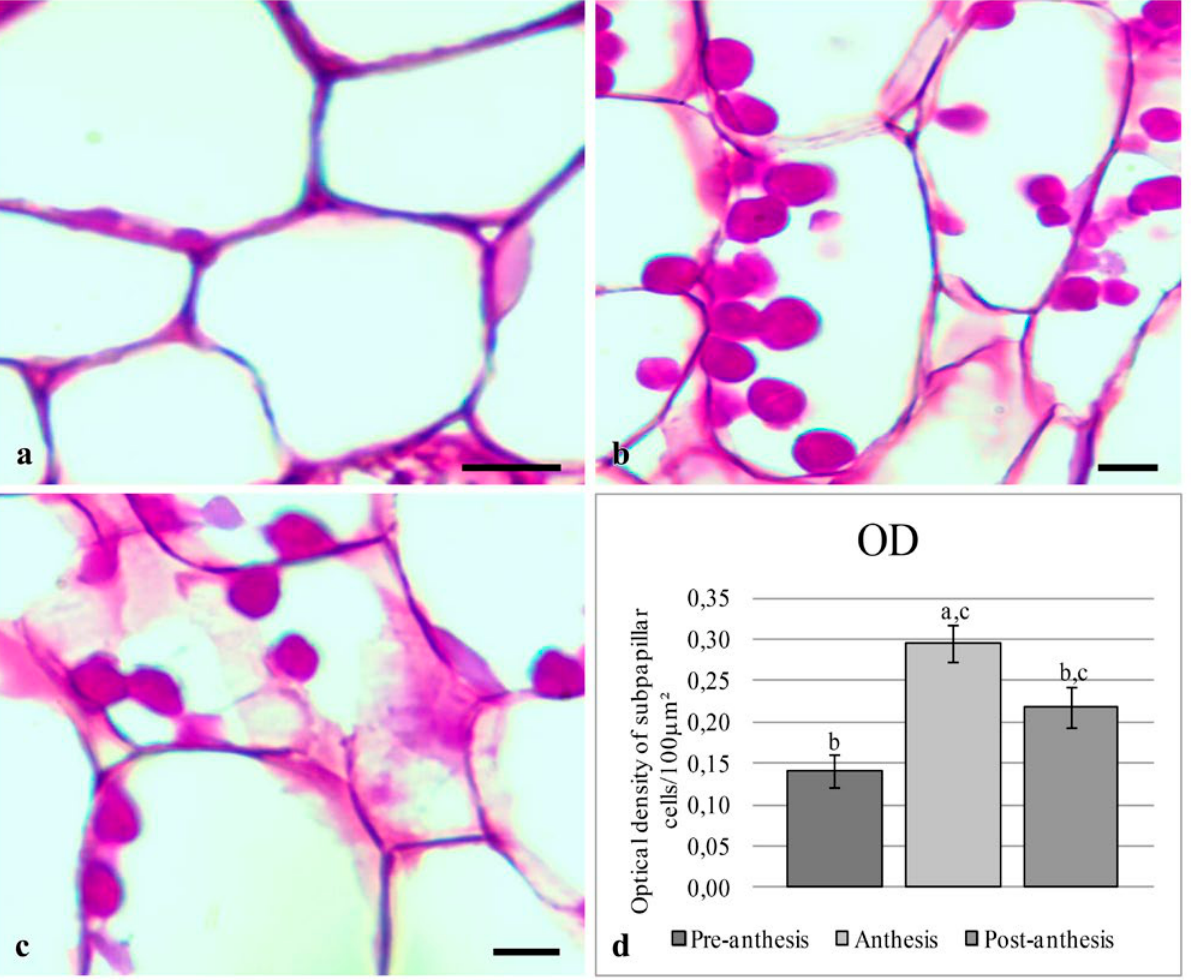
Figure 4. Starch dynamics at sub-papillary cells during stigma development of Hibiscus syriacus . a. Very few starch granules in sub-papillary cells at pre-anthesis, b. Large and dense starch granules in sub-papillary cells at anthesis, c. Starch granule content at post-anthesis (note the reduction in compare to anthesis), d. Starch synthesis/degradation pattern of sub-papillary cells, data are expressed as optical density per area unit (100 µm²). The data with different letters are significantly different according to Tukey’s test at P < 0.05 for independent samples. Results are expressed as mean ± SD. Scale: 5